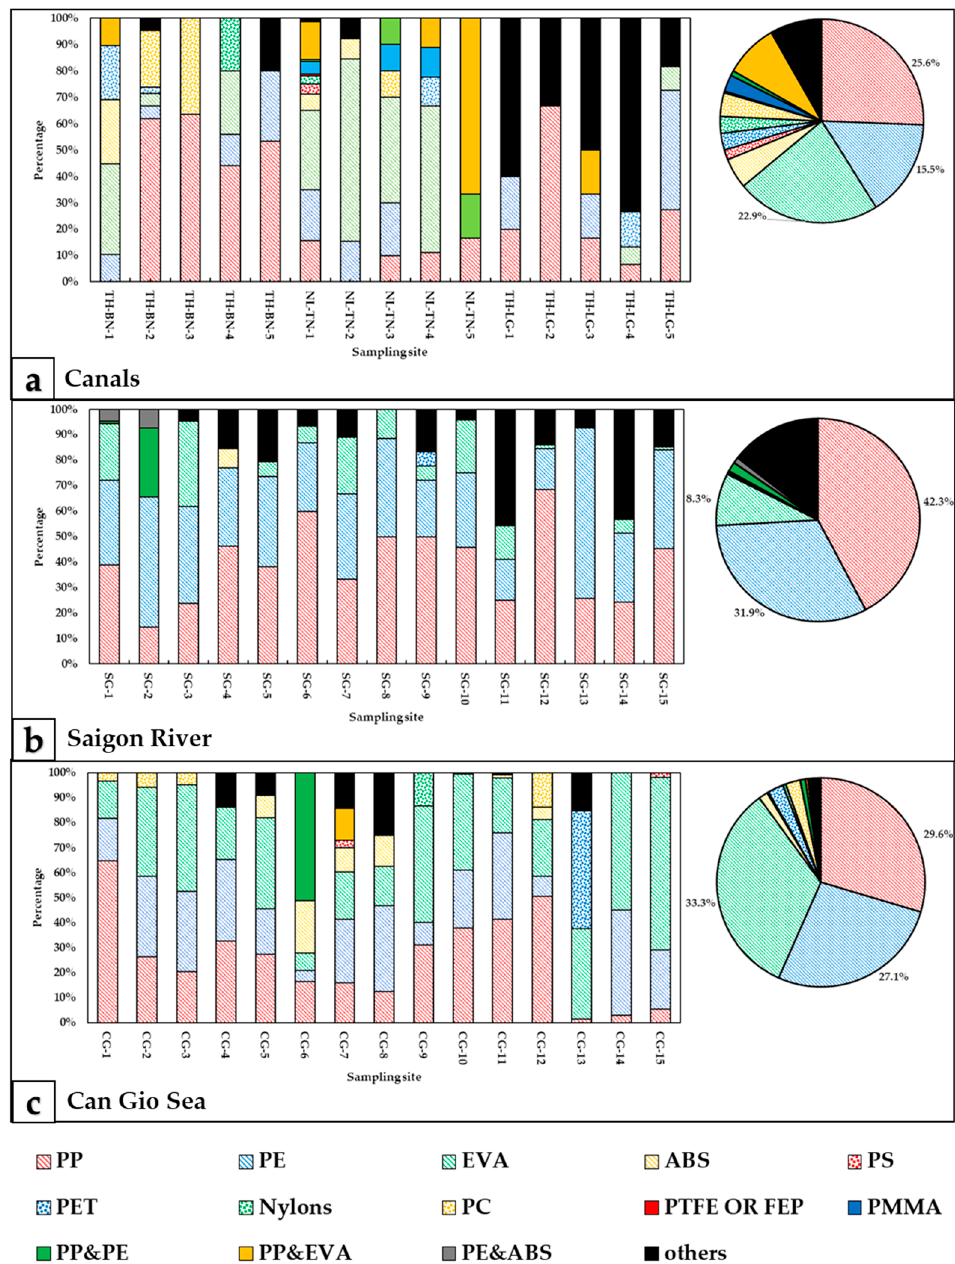
Figure 3. Chemical composition of MPs: ( a ) Canals, ( b ) Saigon River, and ( c ) Can Gio Sea, in August 2020.